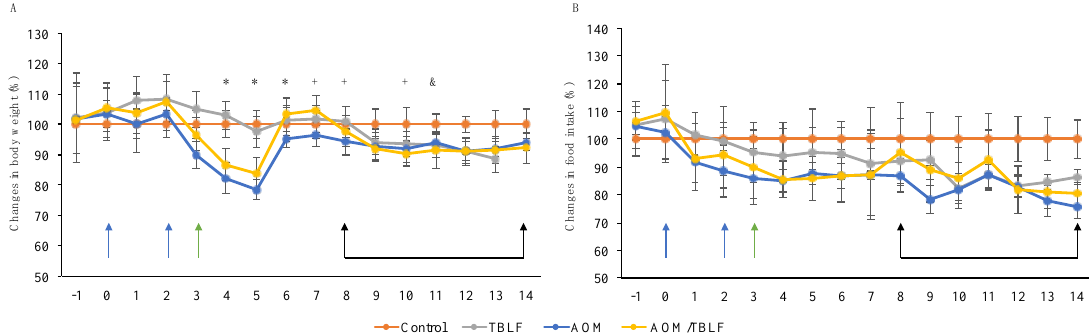
Figure 5. Body weight and food intake changes for the azoxy-methane/dextran sodium sulfate (AOM/DSS) experiment. Rats were intraperitoneally administered for two weeks with AOM (blue arrows) and a further week with dextran sodium sulfate (DSS) in their daily drinking water (green arrow) to develop aberrant cryptic foci (ACF). Next, they were administered TBLF (50 mg/kg) on alternate days for six weeks via intra-gastric cannula (black arrows). ( A ) Weekly body weight monitoring with respect to the control group; ( B ) Average of food intake changes per week with respect to the control group. A one-way ANOVA by Dunnett post hoc showed significant difference (*) p ≤ 0.05, (&) p ≤ 0.01 and (+) p ≤ 0.001. A decrease in weight gain and food intake was observed for all treatments with no recovery at the end of the experiment.